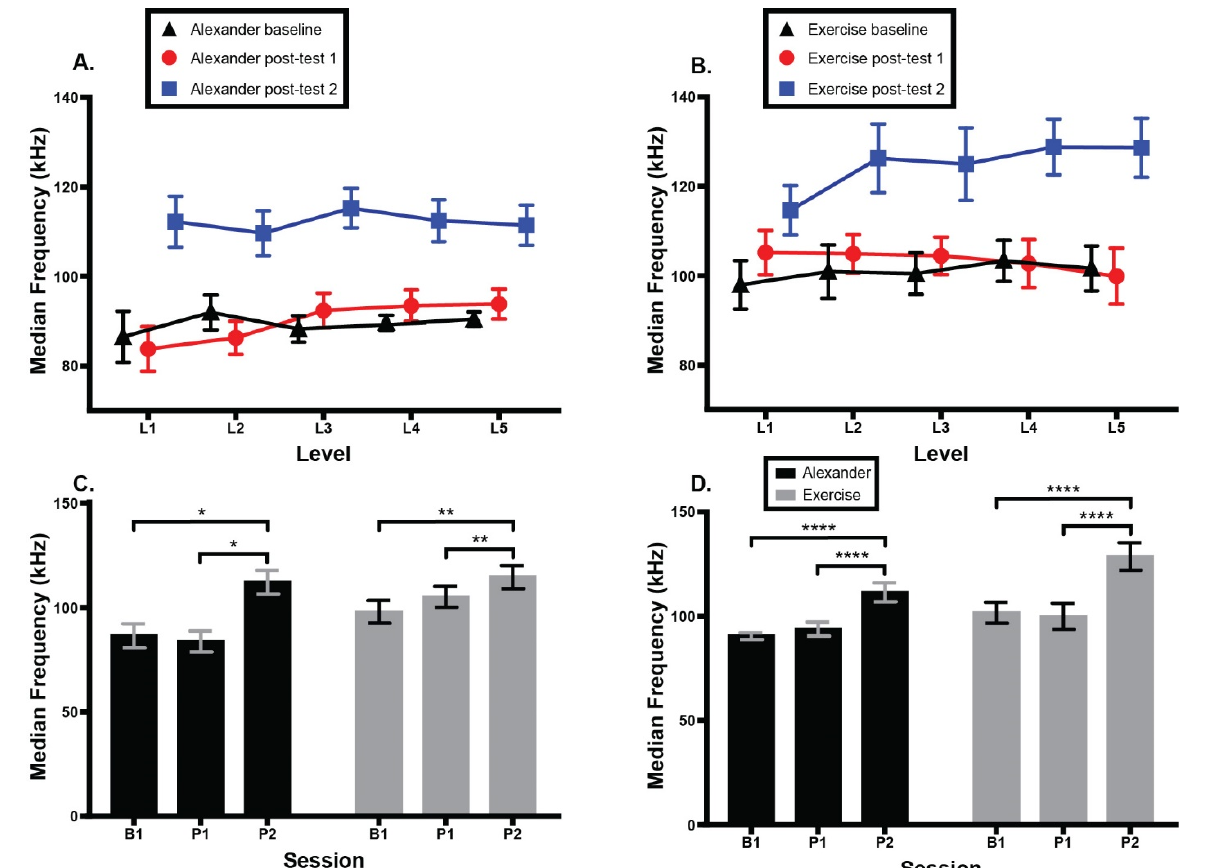
Figure 7. Median frequency of bilateral sternocleidomastoid (SCM) muscle activity during cranio-cervical flexion test (CFFT).). ( A ) Alexander group SCM activity across two groups, three testing sessions, and five CCFT levels. ( B ) Exercise group SCM activity across groups, sessions, and CCFT levels. ( C ) SCM activity across groups and sessions at CCFT Level 1. ( D ) SCM activity across groups and sessions at CCFT Level 5. Error bars indicate the standard error of the mean. Higher SCM activation indicates more muscle activity. * signifies p = 0.01. ** signifies p = 0.007. **** signifies p < 0.0001. B1 = baseline; P1 = 1st post-test; P2 = 2nd post-test.